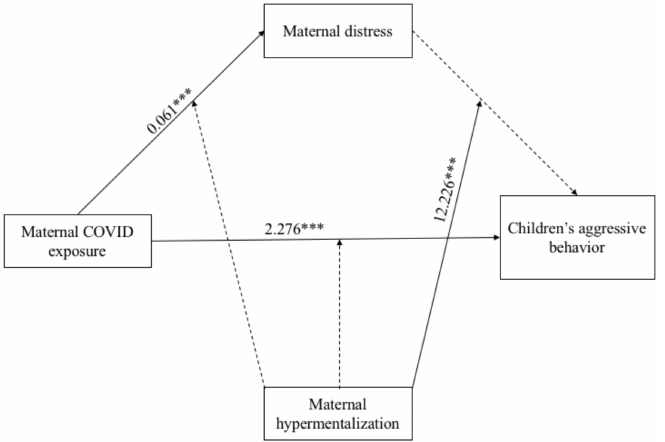
Figure 6. Results of the Moderation Mediated Model 3. Note: *** p < 0.001. Only significant path coefficients are displayed; not significant paths were displayed by dotted lines. The covariates are not displayed here, but they were estimated in the